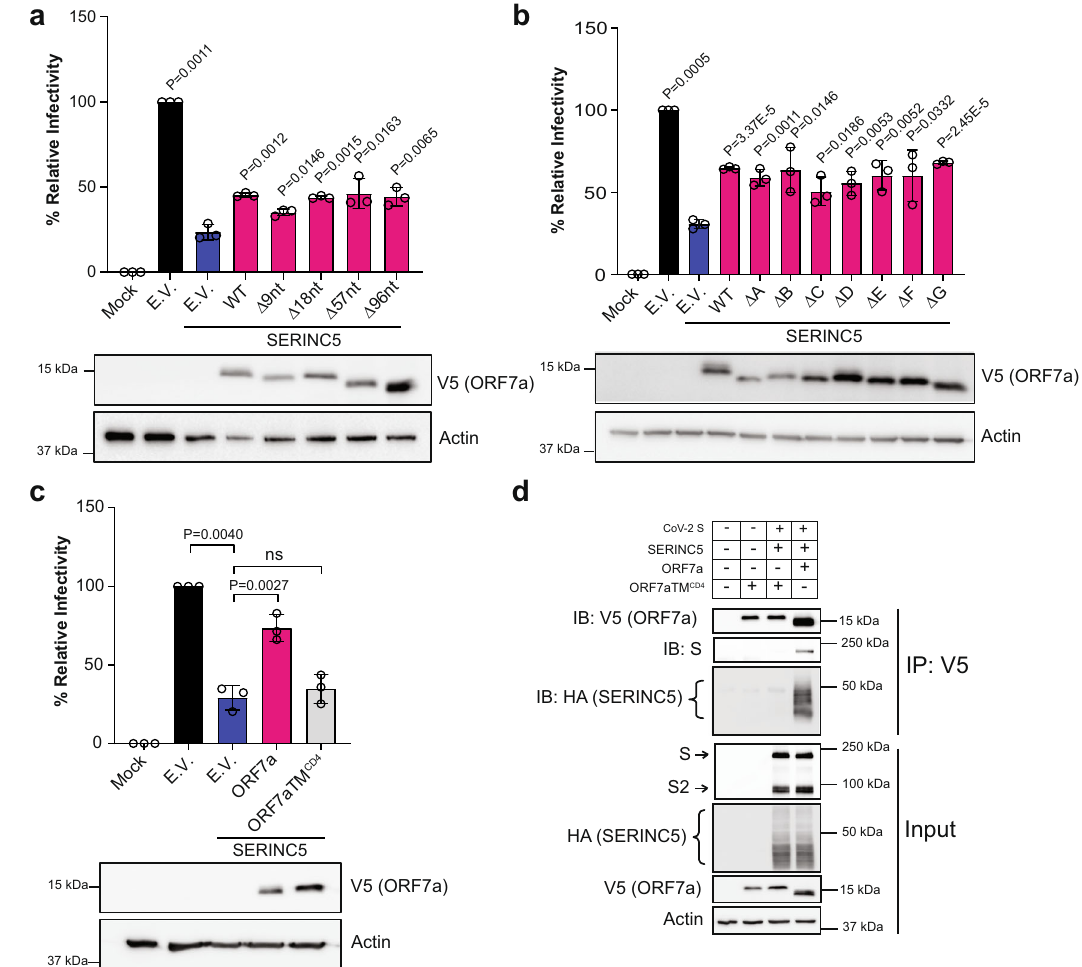
Fig. 8 ORF7a transmembrane domain is responsible for counteracting SERINC5 restriction of SARS-CoV-2 entry. Naturally occurring SARS-CoV-2 ORF7a deletions and the β -sheets of the SARS-CoV-2 ORF7a ectodomain do not affect its anti-SERINC5 function. 293T-hACE2 cells were infected with SARS- CoV-2 S pseudoviruses produced in the presence or absence of SERINC5 along with a naturally occurring deletion variants of SARS-CoV-2 ORF7a or b β -sheet deletion mutants of SARS-CoV-2 ORF7a. c The SARS-CoV-2 ORF7a transmembrane domain is critical for its anti-SERINC5 function. 293T-hACE2 cells were infected with SARS-CoV-2 S pseudoviruses produced in the presence or absence of SERINC5 along with either wild type ORF7a or ORF7-CD4 transmembrane domain chimera (ORF7aTM CD4 ). For a , b , and c , luciferase levels were normalized to p24 CA levels. The percentage (%) of relative infectivity with respect to pseudovirus produced in the presence of empty vector is shown. All results are presented as mean±SD from 3 independent experiments. Statistical analysis among E.V. and SERINC5 + E.V. conditions were performed by one-sample t test (two-tailed) while unpaired t-test (two-tailed) was used for comparisons among SERINC5 + E.V. and SERINC5 + ORF7a groups. Representative immunoblotting results of the expression levels of SARS-CoV-2 ORF7a variants or mutants in the producer cell lysates is shown at the bottom. d Transmembrane domain of SARS-CoV-2 ORF7a is required for its interaction with SARS-CoV-2 S and SERINC5. 293T cells were cotransfected with SARS-CoV-2 S, SERINC5, SARS-CoV-2 ORF7a, SARS-CoV-2 ORF7aTM CD4 or empty vector as indicated. Cells were harvested and lysates were immunoprecipitated with anti-V5 antibody followed by immunoblot analyses probing for the indicated proteins. Representative immunoblotting results from n = 3 independent experiments are shown. Uncropped blots are in Source Data. (empty vector, E.V.; wild type SARS-CoV-2 ORF7a, WT; SARS-CoV-2 ORF7a Δ 9nt, Δ 9nt; SARS-CoV-2 ORF7a Δ 18nt, Δ 18nt; SARS-CoV-2 ORF7a Δ 57nt, Δ 57nt; SARS-CoV-2 ORF7a Δ 96nt, Δ 96nt; SARS-CoV-2 ORF7a Δ A, Δ A; SARS-CoV-2 ORF7a Δ B, Δ B; SARS-CoV-2 ORF7a Δ C, Δ C; SARS-CoV-2 ORF7a Δ D, Δ D; SARS-CoV-2 ORF7a Δ E, Δ E, SARS-CoV-2 ORF7a Δ F, Δ